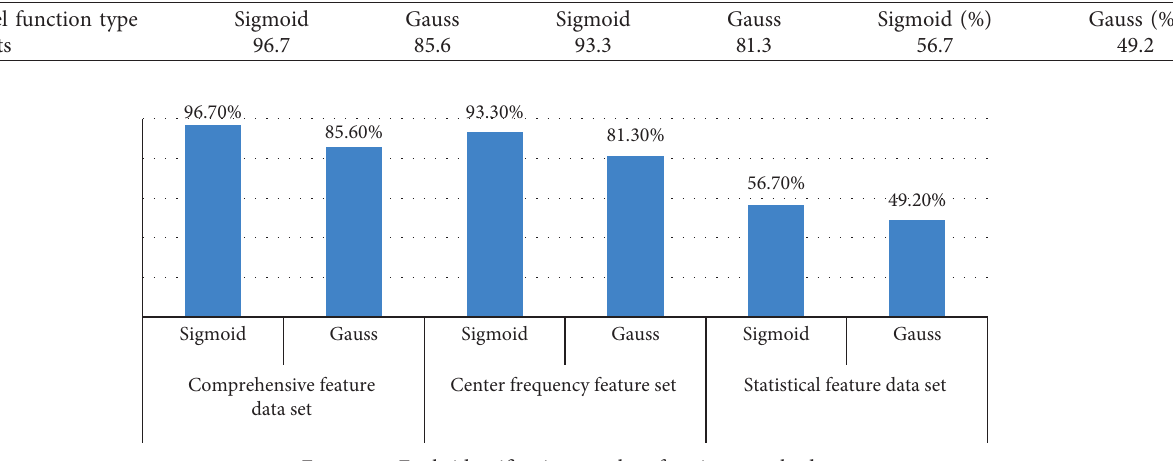
Figure 7: Fault identification results of various